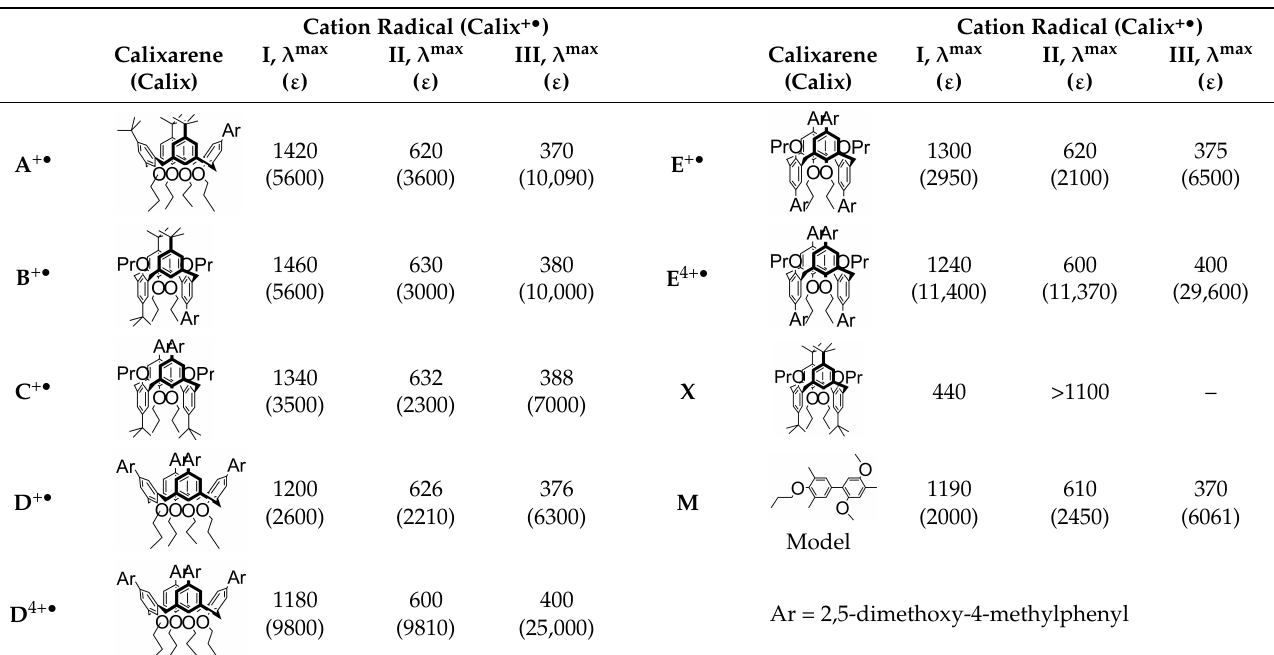
Spectral properties of various calixarene mono-cation and/or tetra-cation radicals in dichloromethane at 22 ◦ C. Generated by using either MB + • , MA + • , or NAP + • under an argon